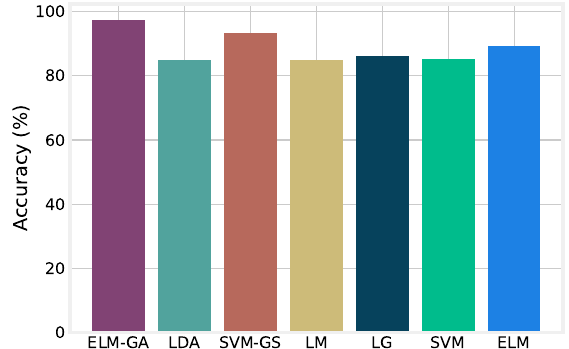
Figure 14. Accuracy of proposed technique with respect to